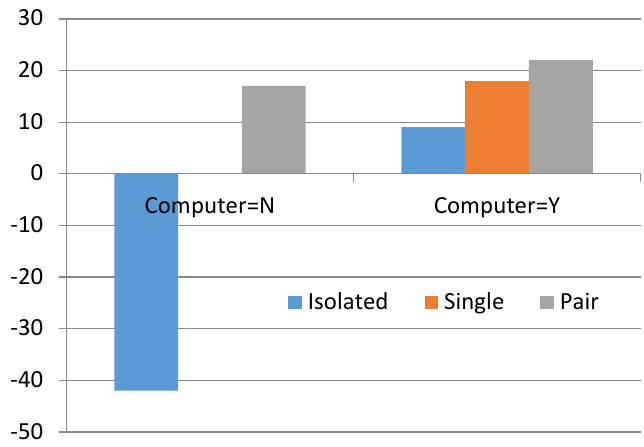
Figure 2 . Change in Wellbeing Index as a function of manipulations of social housing and computer-task